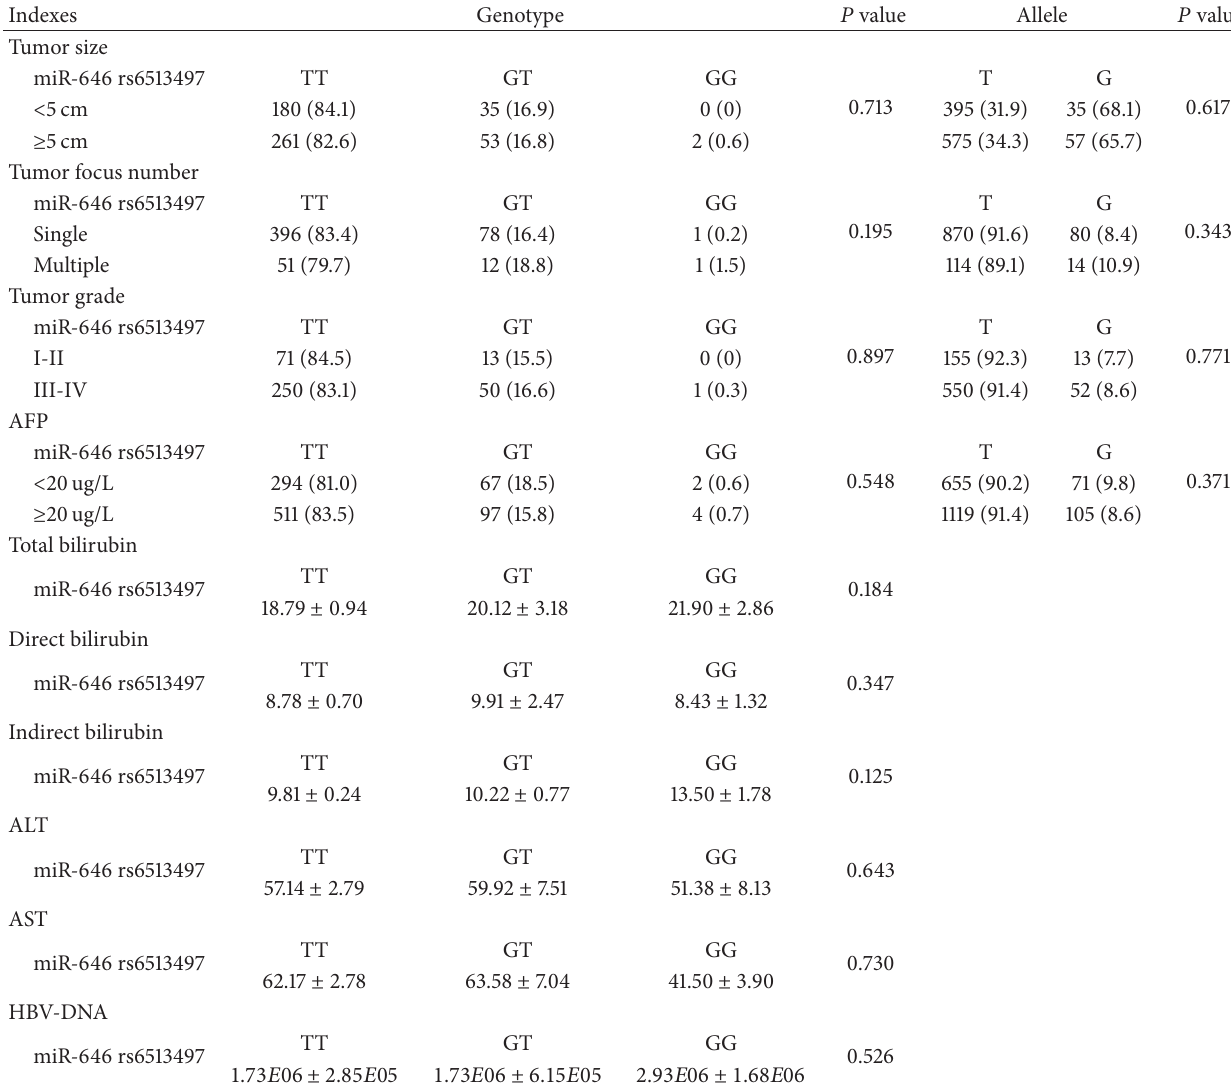
Table 5: Clinicopathologic characteristics and genotype/allele frequencies of miR-646 rs6513497 in HCC